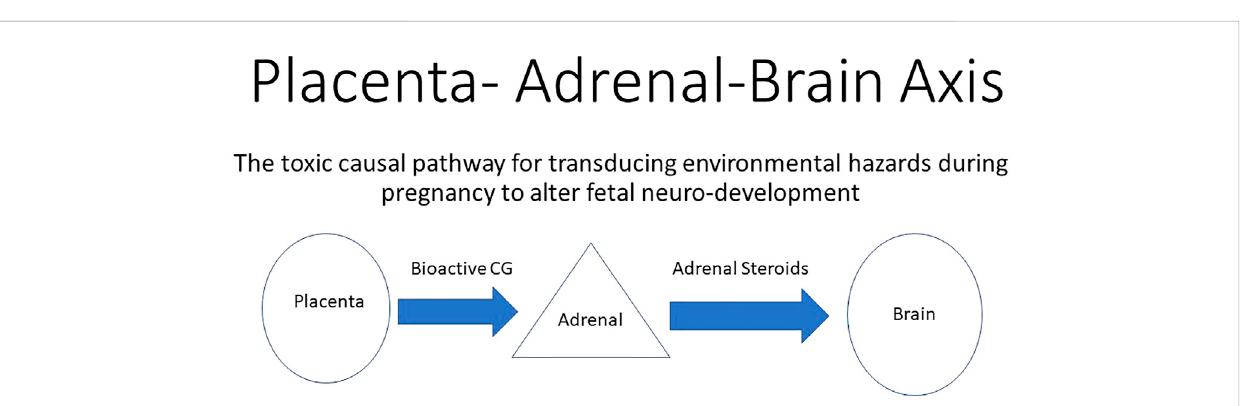
FIGURE 2 Environmentaladverseeffectsontheplacentathatdirectlyreducestheproductionofbioactivechorionicgonadotropin(CG)thatactsonfunctional LH/CG receptors in the fetal adrenals. A reduction in bioactive CG results in decreased support of the fetal adrenals. Reduced adrenal steroid hormone production leads to abnormal fetal brain development and ultimately leads to neurological defects in the neonate. In this way, adverse effects on the placenta indirectly alter neurodevelopment by altering the production of adrenal